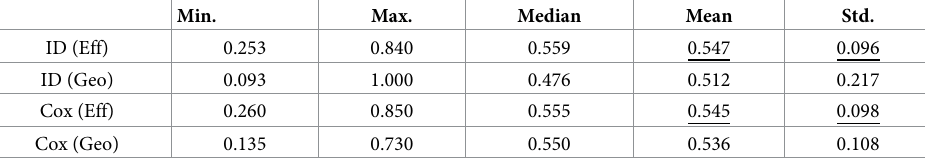
Table 6. Descriptive statistics of the arrival probability based on the Cox model and the effective distance model.